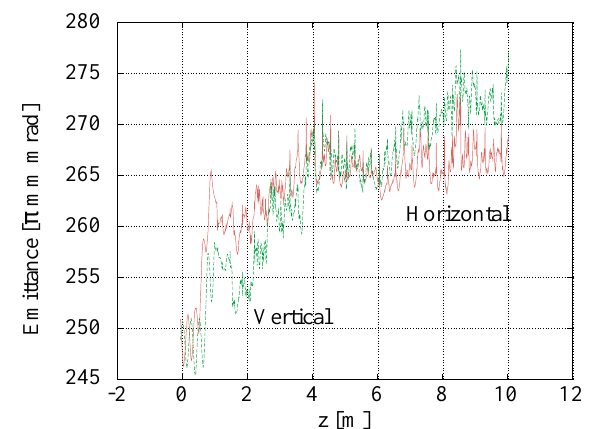
FIG. 11. (Color) Evolution of normalized rms transverse emit- tances (horizontal: solid red line; vertical: dashed green line).